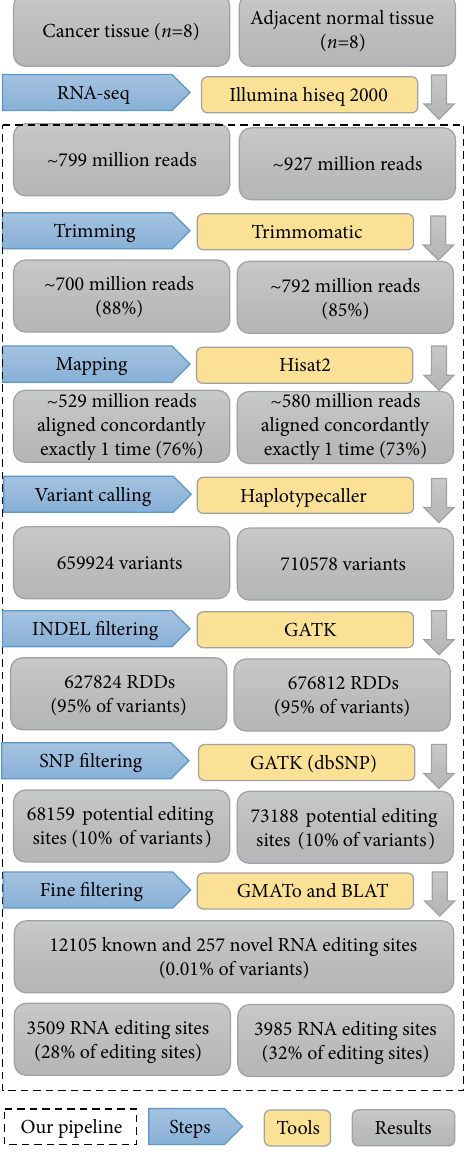
Figure 1: Bioinformatical approach used for the identi fi cation of RNA editing sites in normal and cancerous gastric tissue from RNA-seq